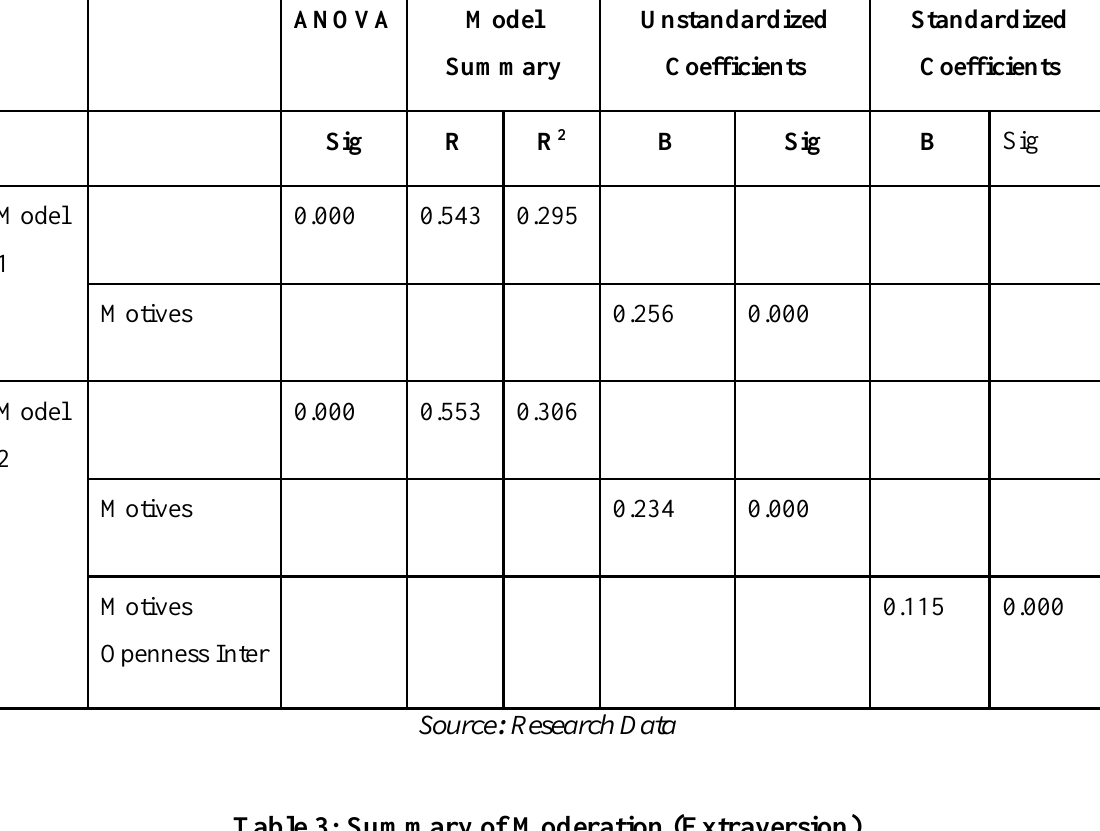
Table 3: Summary of Moderation (Extraversion)